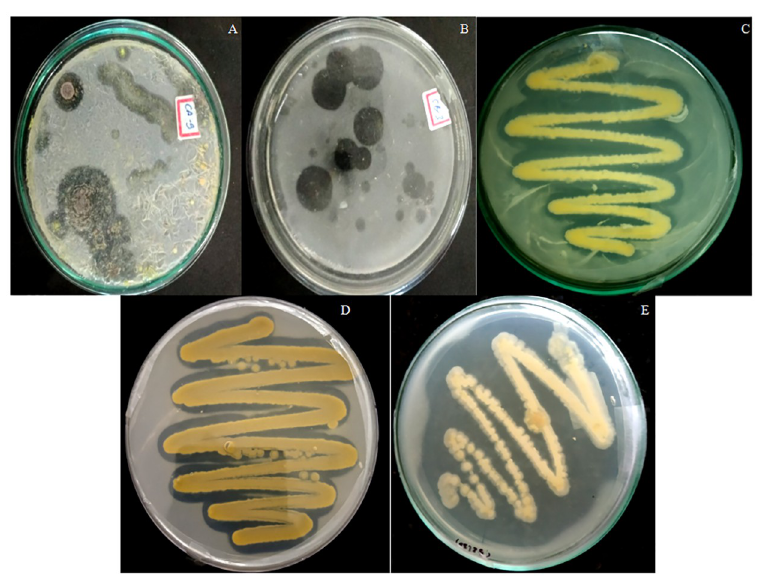
Fig 1. Images showing clear zone of diameter of microbial colonies in (A) and (B). Positive colonies showing PHB hydrolysis on PHB agar media (C) CA6-(55), (D) CB2-(20), and (E) Kuk1-(34).